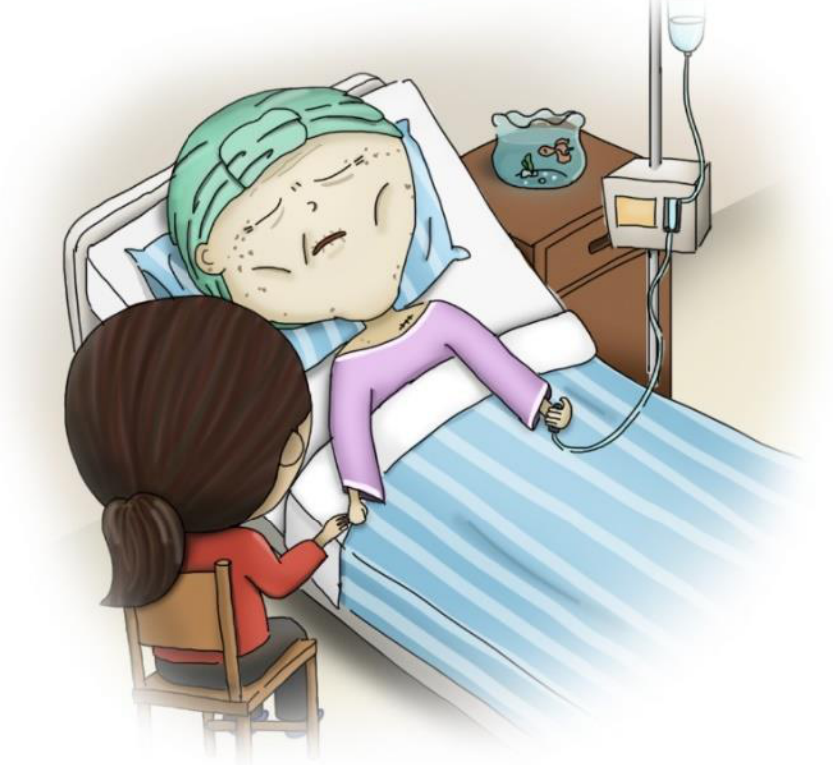
Figure 6. Terminal cancer with pain.